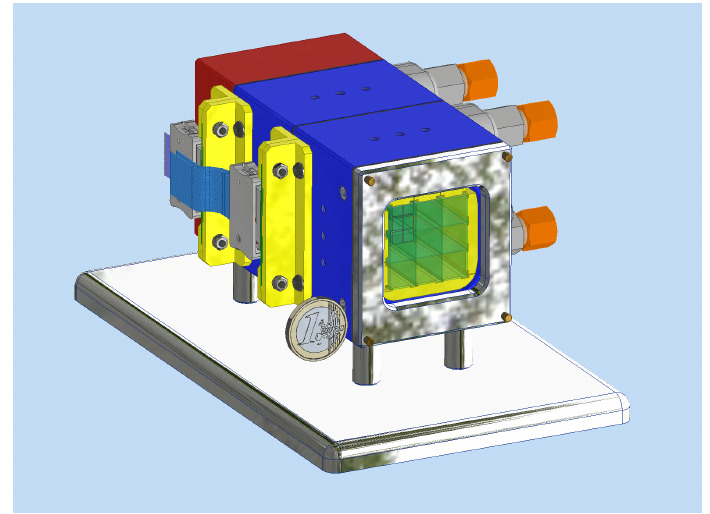
Figure 1. CAD 3D model of Crilin Prototype